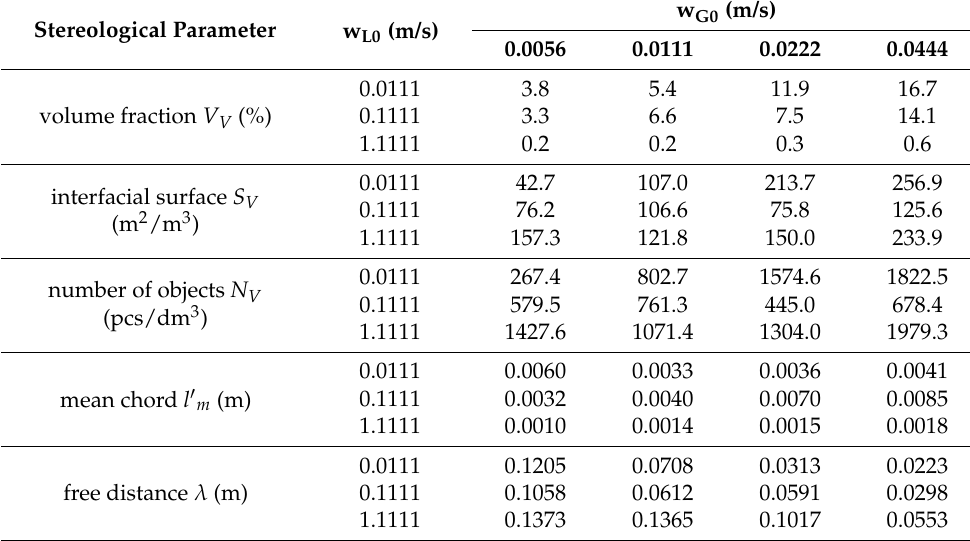
Table 3. Matrix of the stereological parameters for analyzed flow rates. Stereological